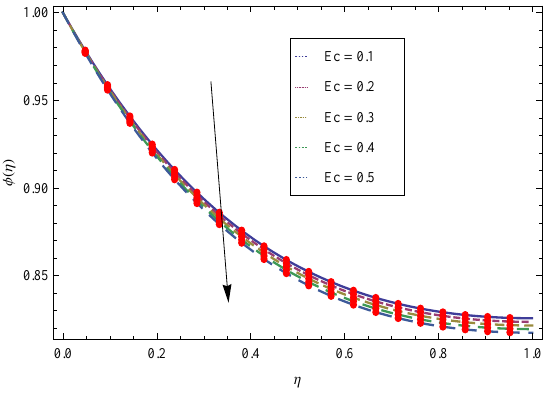
Figure 17. Shows the effect of Ec on θ ( η ) , for h = − 0.6, λ = 0.1, S = 0.1,kr = 0.9, Pr = 15,Nb = 0.5, Nt = 0.6, β = 1 and Sc = 0.1.